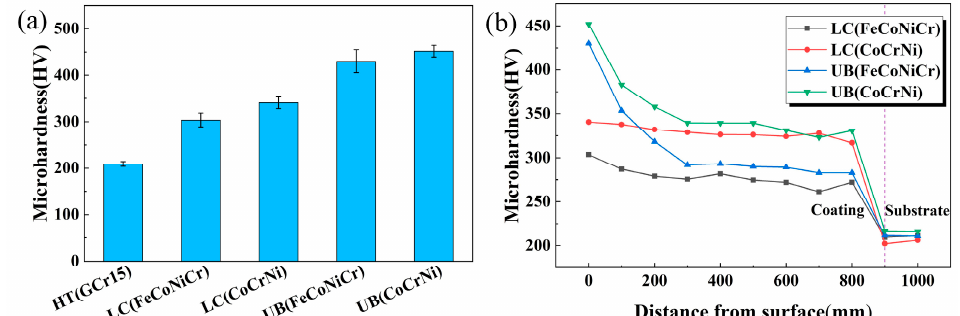
Figure 9. Micro-hardness results. ( a ) Surface hardness; ( b ) cross-section hardness variations.